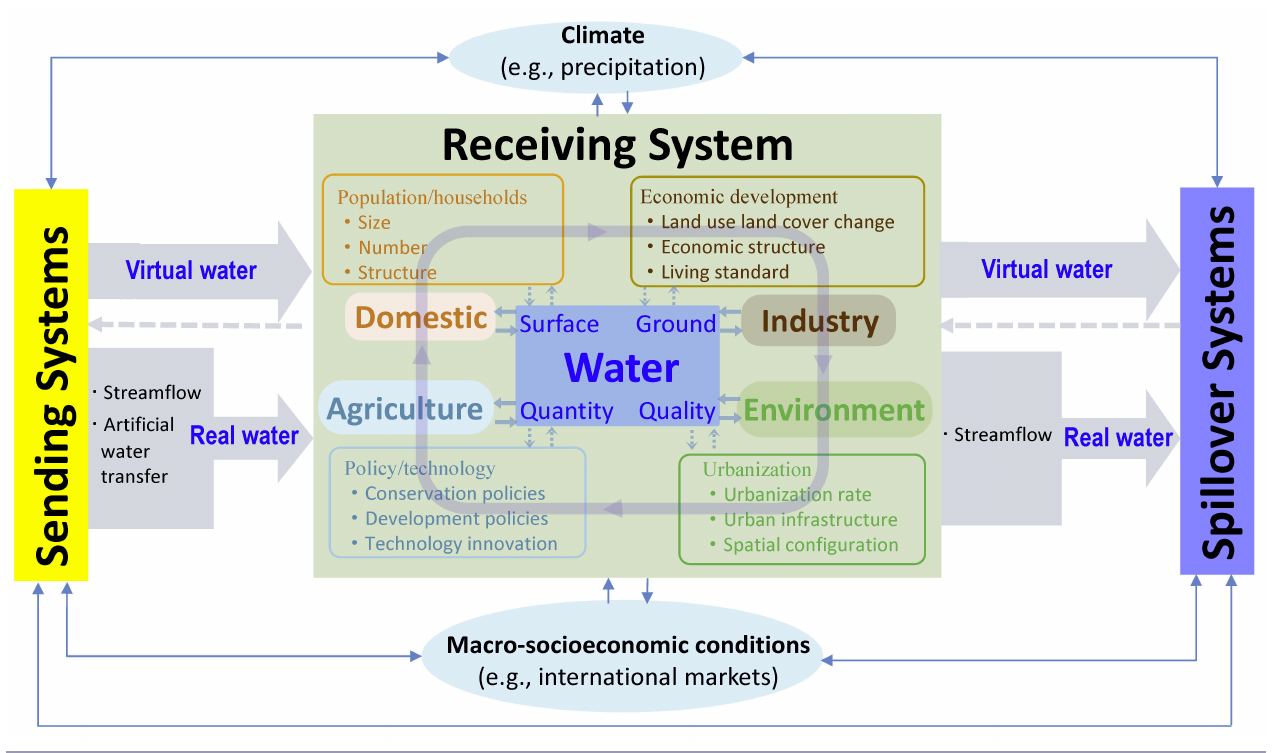
Fig. 1 . Conceptual framework for analyzing urban water sustainability. Arrows indicate directions of interactions and feedbacks. For the sake of simplification, the figure does not show causes, agents, and effects in sending, receiving, and spillover systems; local couplings within sending and spillover systems; or other flows (except water) of people, technology, and knowledge between systems. For more descriptions, please refer to the